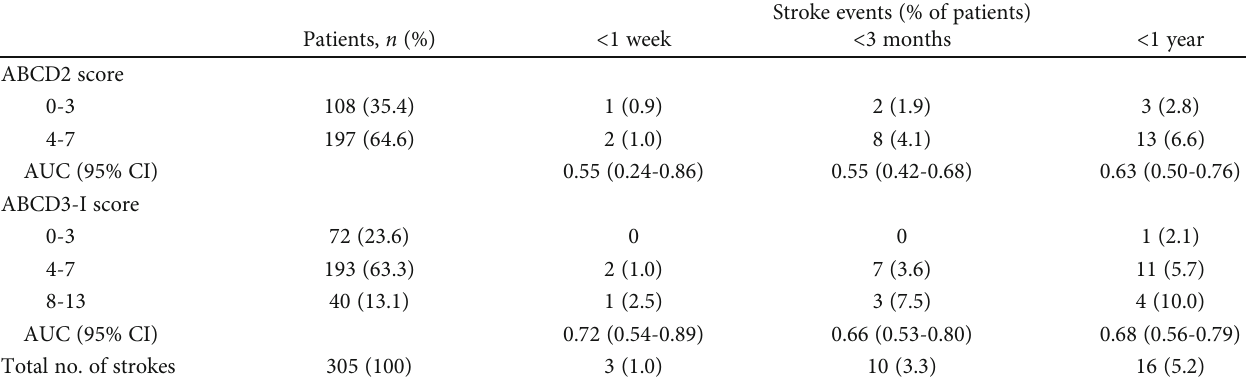
Table 3: The 1-week, 3-month, and 1-year risks of stroke according to cuto ff values of the ABCD2 and ABCD3-I scores with corresponding AUC